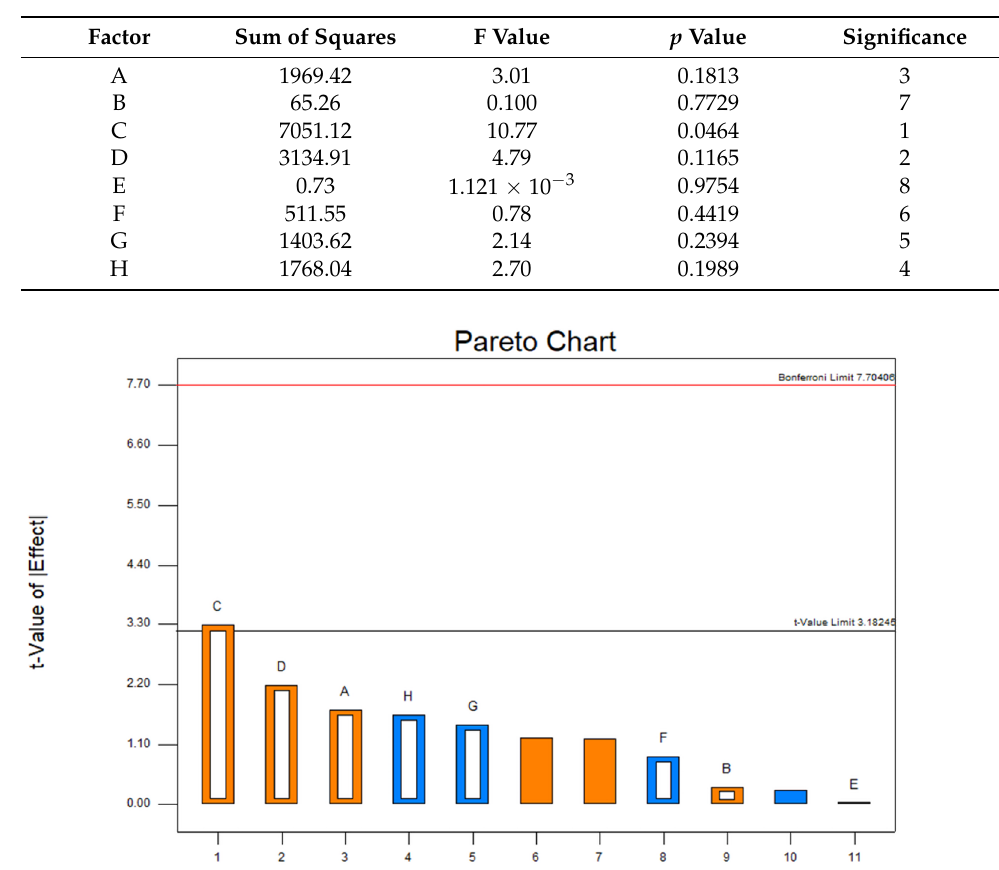
Figure 18. Pareto chart of the PB test.